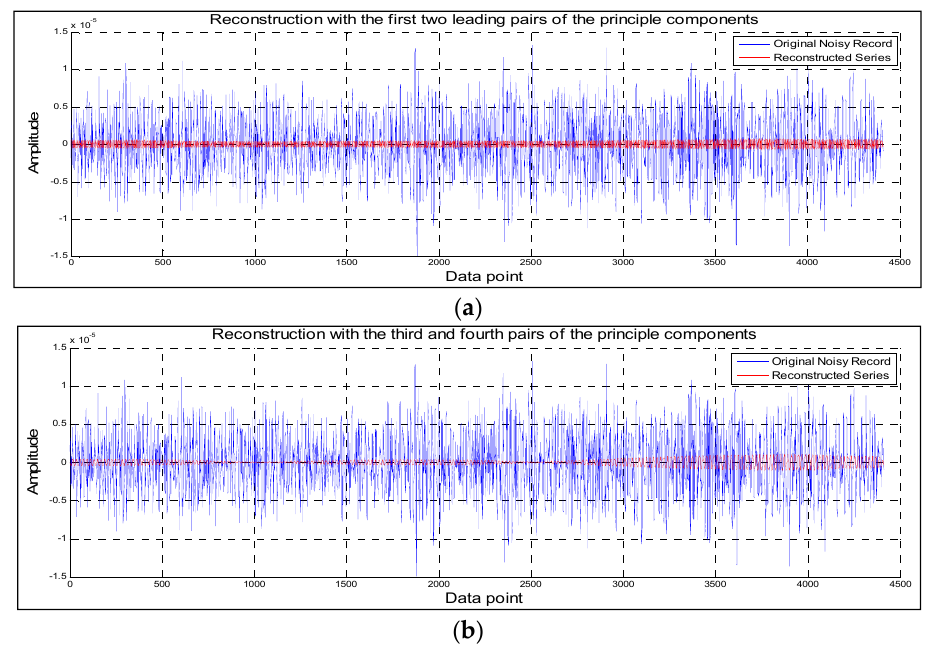
Figure 8. The leading four principle components used for grouping and reconstruction and the record of birds’ chirps with additive wind noise: ( a ) Reconstruction with the first two leading pairs of the principle components; ( b ) Reconstruction with the third and fourth principle components pairs.